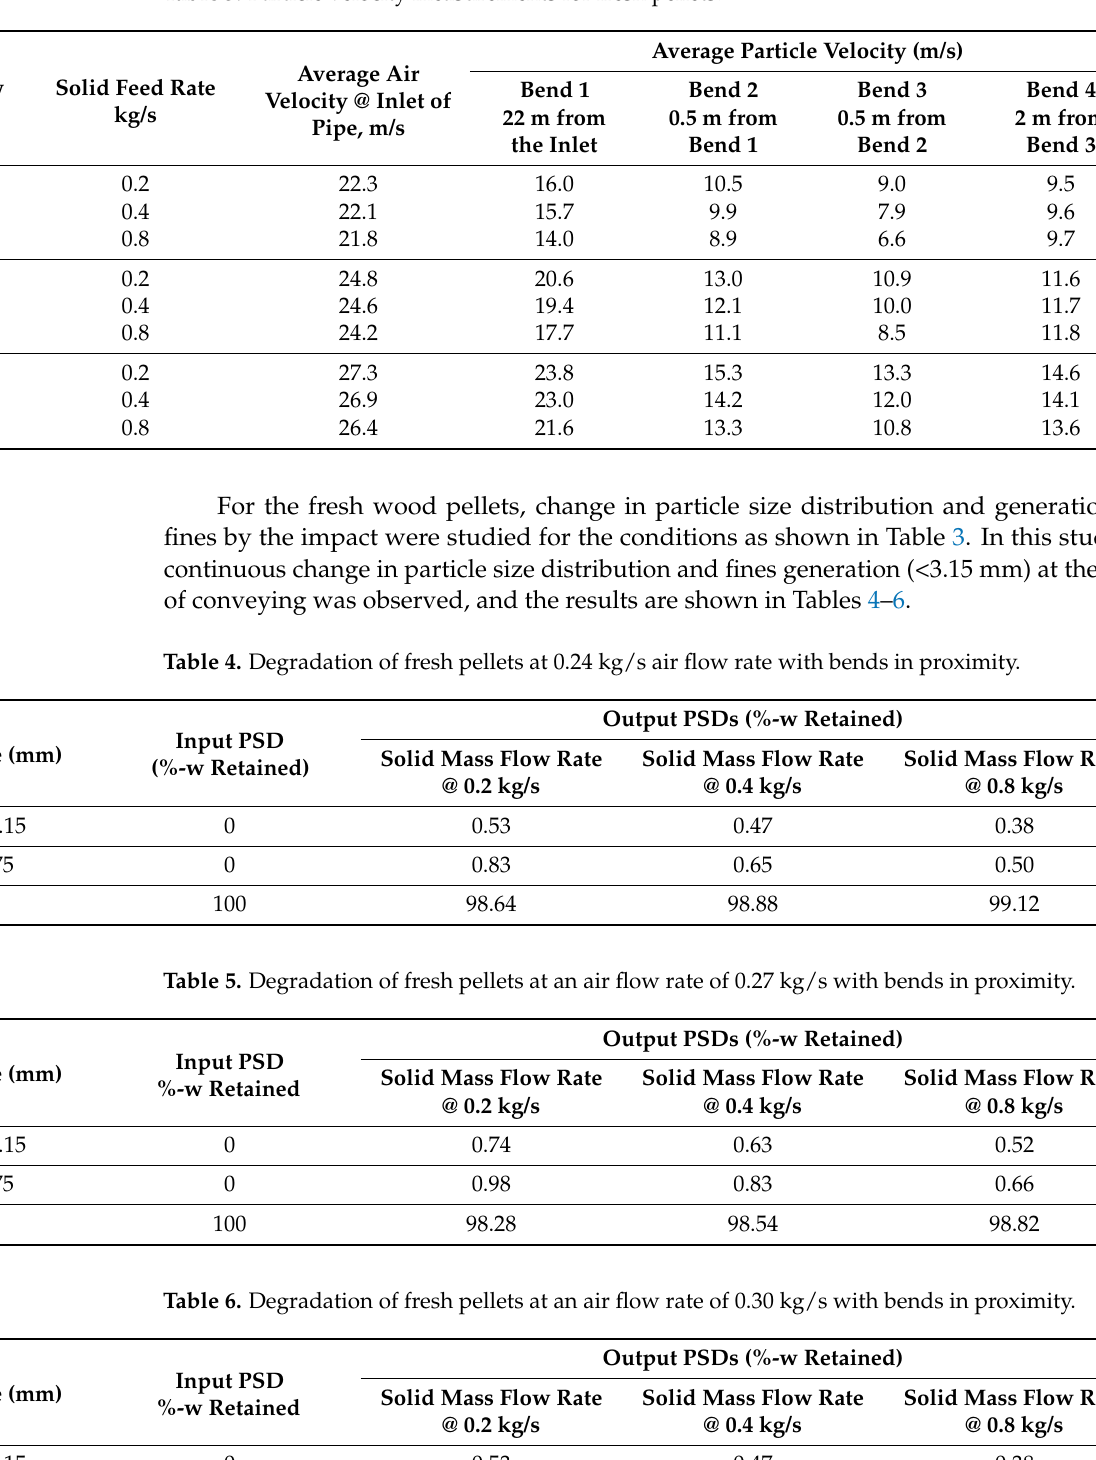
Table 3. Particle velocity measurements for fresh pellets.